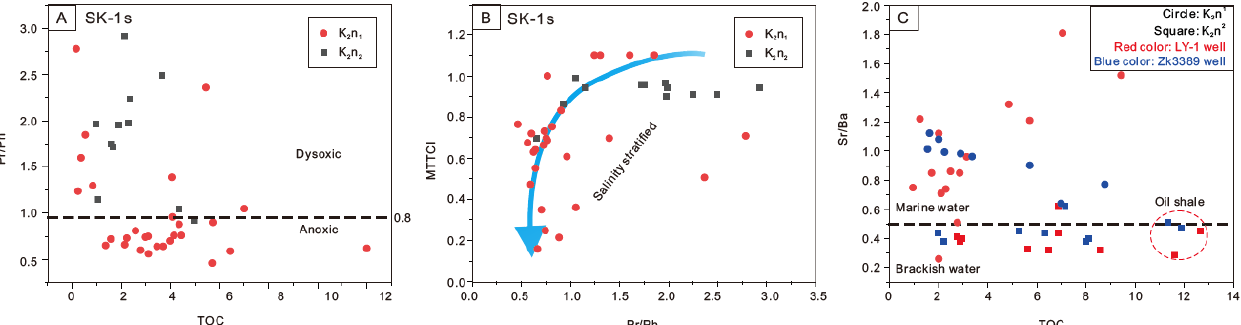
Figure 4. Cross-plot of paleoenvironmental proxies for the Nenjiang Formation in the Songliao Basin. ( A ) Correlation